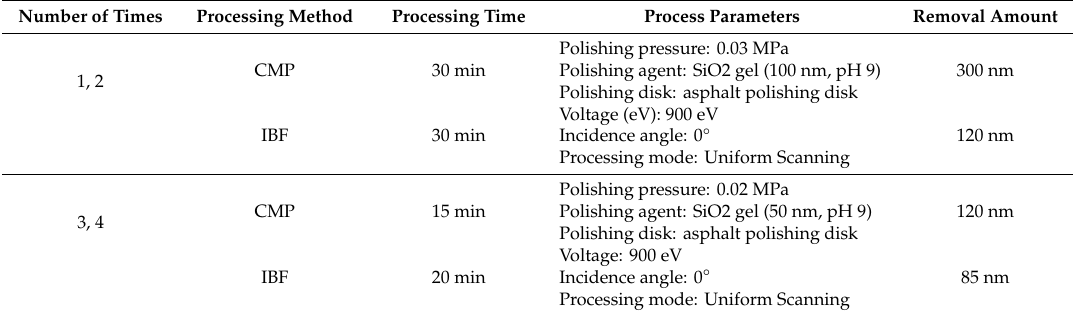
Table 8. Parameters of Combined Process